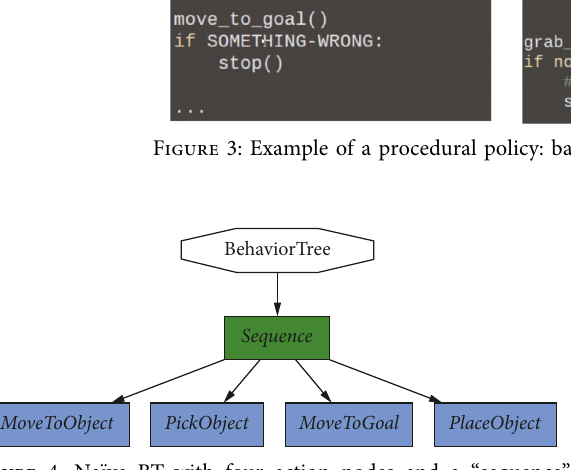
Figure 4: Na¨ıve BT with four action nodes and a “sequence” control flow node.